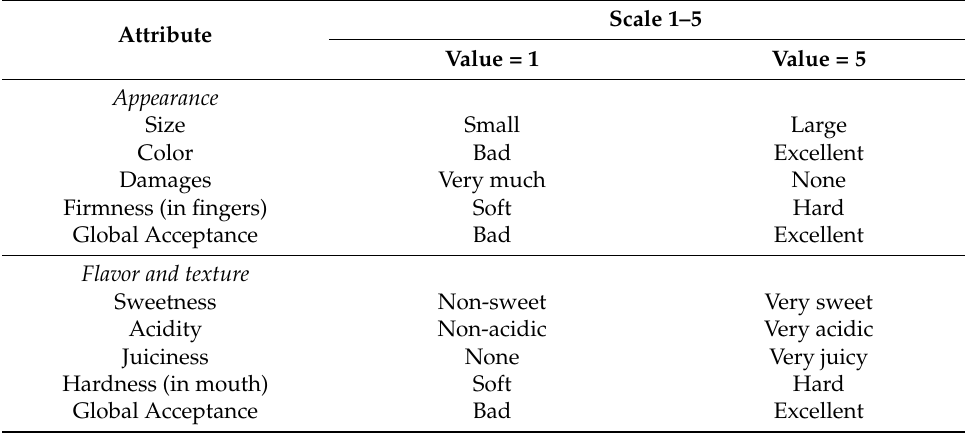
Table 2. Attributes scored by a sensory evaluation panel to loquat fruit